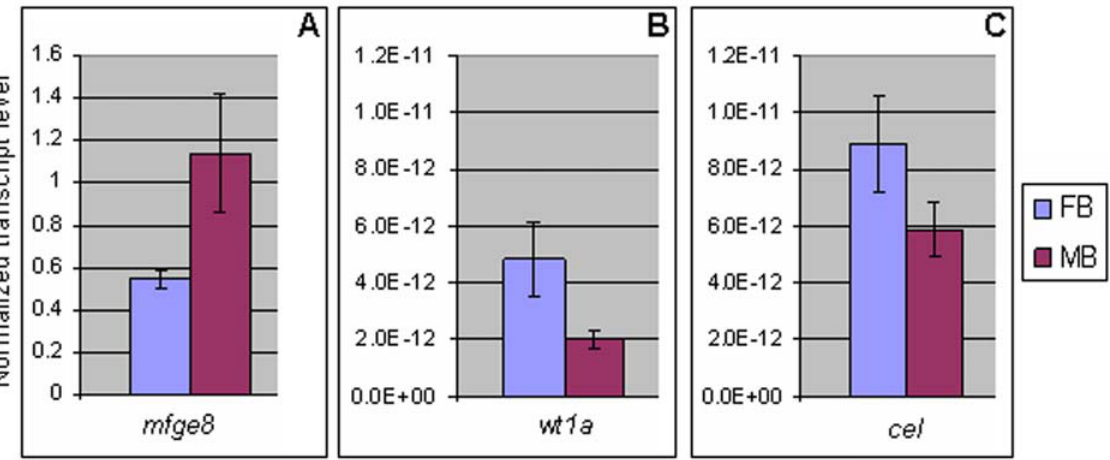
Figure 5. Real-time PCR analysis of selected genes which showed sexually dimorphic expression in the zebrafish brain. Normalized transcript levels in the female (FB) and male brain (MB) for genes mfge8 (A), w t1a (B), and cel (C) are shown. The real-time PCR revealed sexually dimorphic expression of these genes in the brain, thereby validating our array data. doi:10.1371/journal.pone.0001791.g005 PLoS ONE |